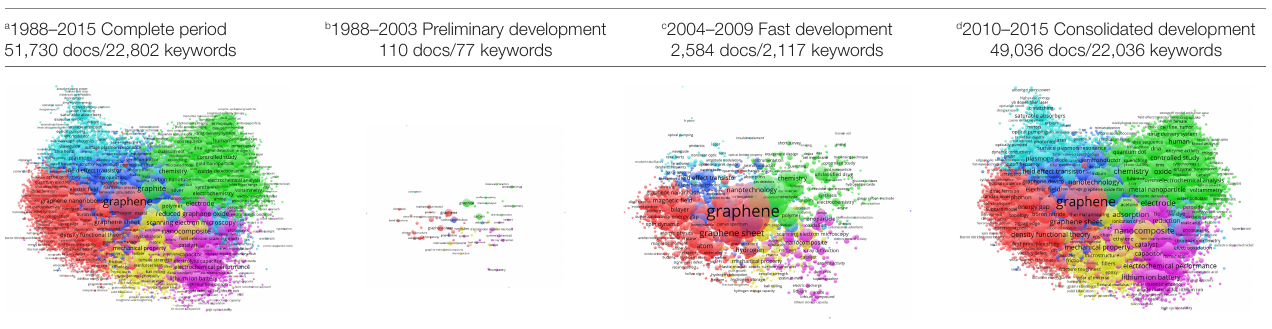
TaBle 2 | World intellectual structure of graphene research and its